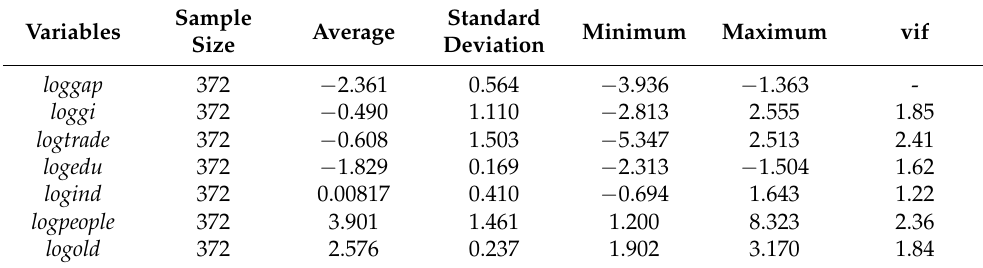
Table 2. Descriptive statistical results of main variables.